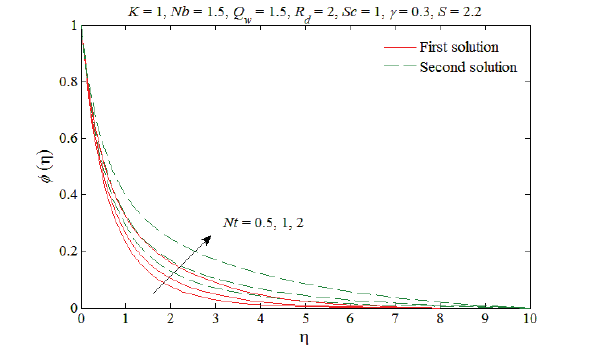
Fig. 10: The temperature profiles for different values of R d .